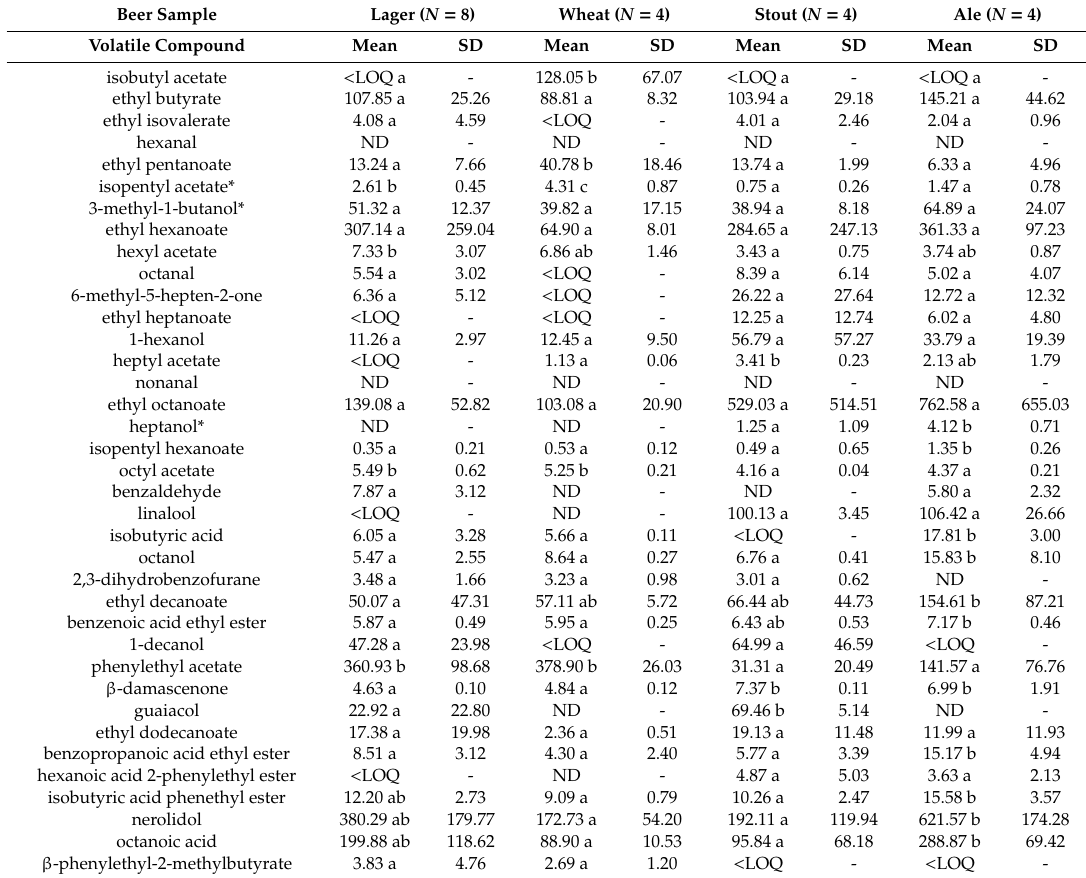
Table 3. Concentrations ( µ g / L) determined of volatile compounds in beers by HSSE–GC–MS. Beer